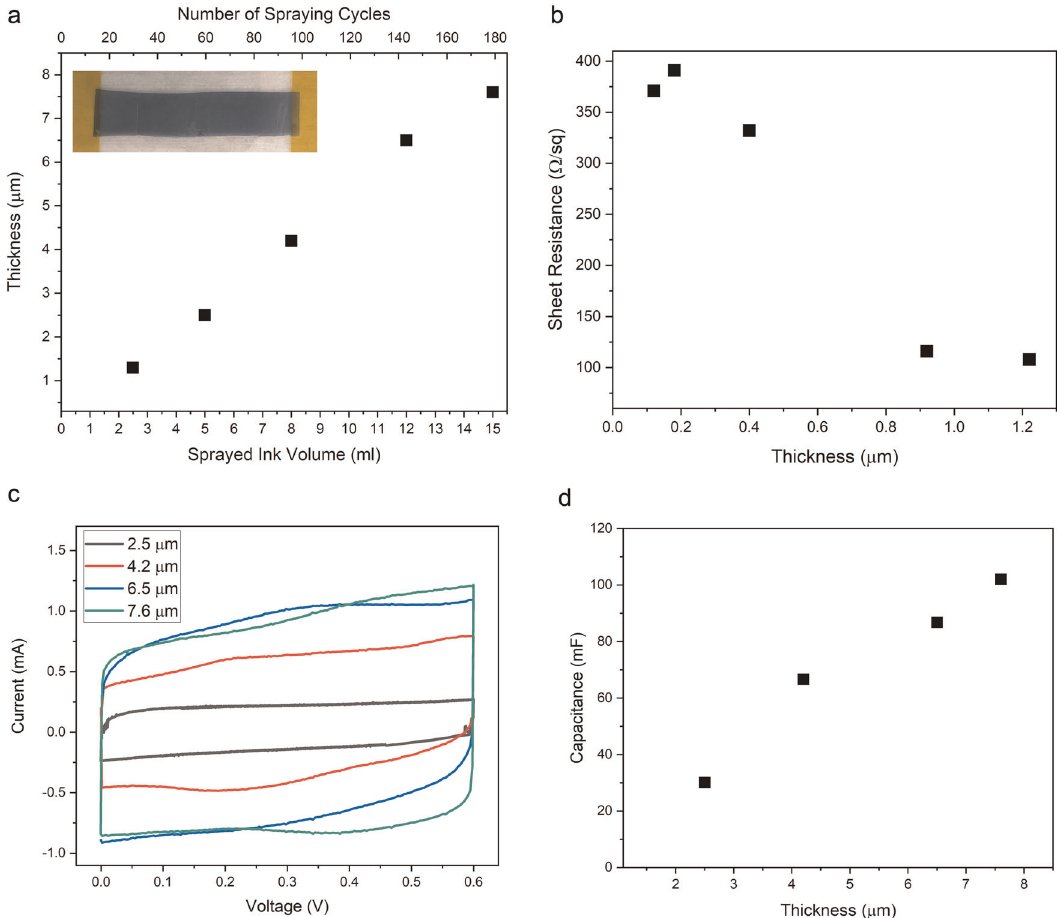
Fig. 2 Paper electrode characterization. a Thickness of the power paper with respect to used ink volume and number of spraying cycles. Inset image shows the 2.5 µ m sprayed power paper on glass substrate. b Sheet resistance values of the sprayed power paper electrodes on glass with different thicknesses. c CV curves of printed paper supercapacitors with different ink volumes at a scan rate of 10 mV/s. d Capacitance values of paper supercapacitors with different power paper fi lm